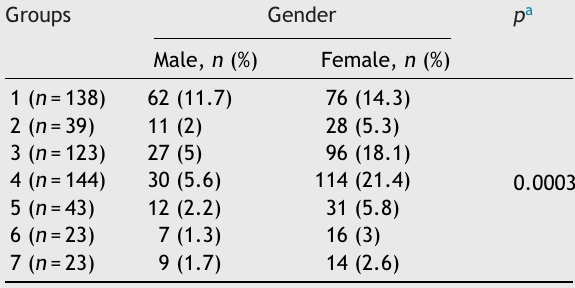
Patient distribution n (%) in each group in relation to